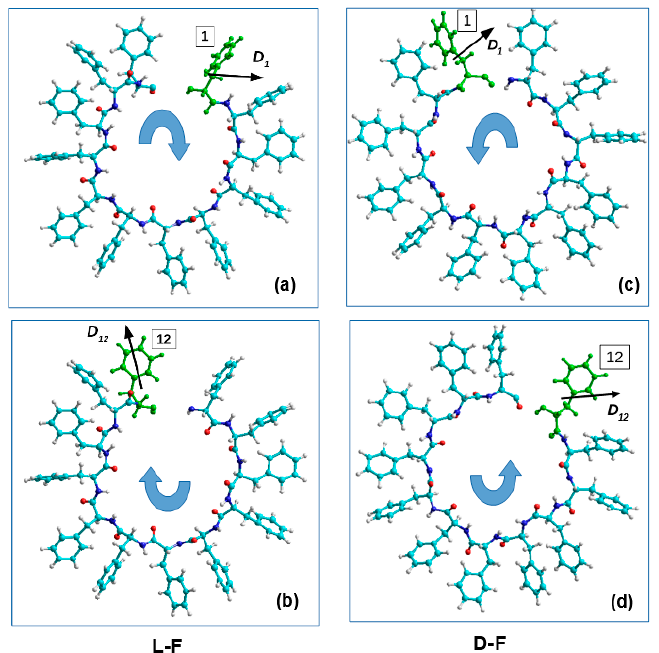
Figure 9. Schematic of the selection procedure of each consequential phenylalanine F molecule (from 1 up 12) from one corresponding coil of helix and the calculation of its dipole moment D i (for i = 1, …, 12) (in Z-projections): ( a , b )–for the L-F PNT; ( c , d )–for the D-F PNT, correspondingly.